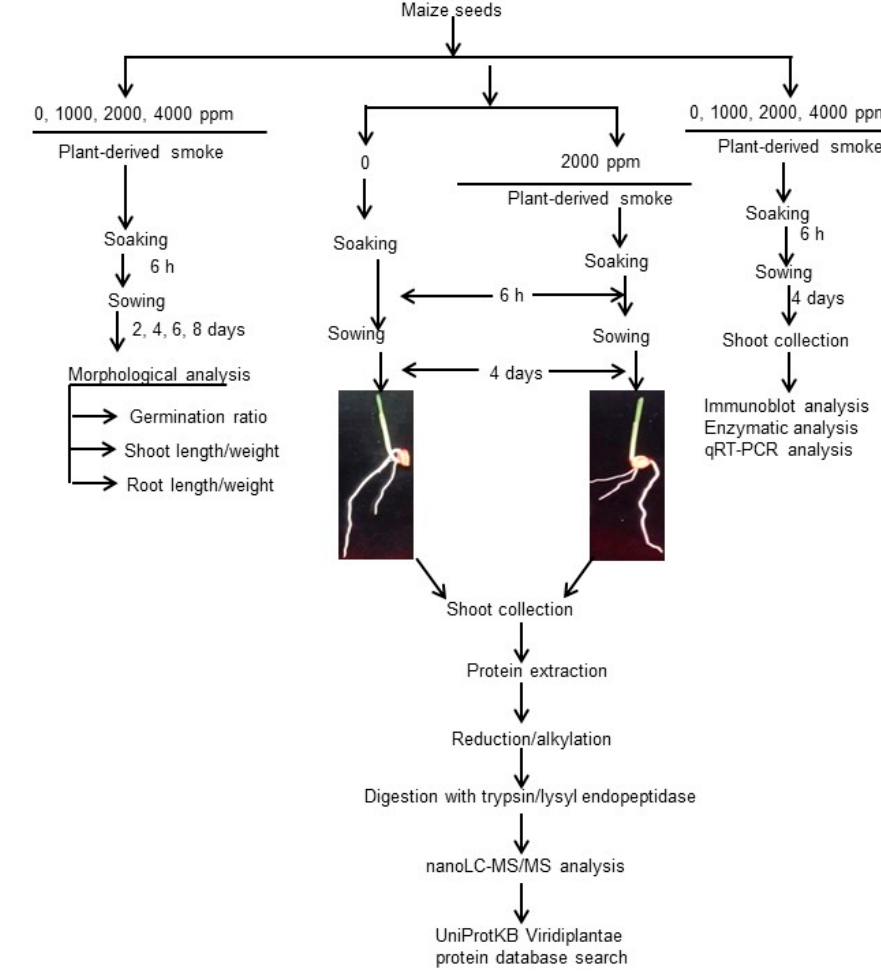
Figure 1. Experimental design for the effects of plant-derived smoke on maize growth. Maize seeds were soaked without or with 1000 ppm, 2000 ppm, and 4000 ppm plant-derived smoke for 6 h and grown in sand. For morphological analysis, germination ratio, shoot/root length, and weight were measured at 2, 4, 6, and 8 days. For proteomic analysis, maize seeds were soaked with 2000 ppm plant-derived smoke for 6 h. Shoot was collected after 4 days. Proteins were extracted, reduced, alkylated, digested, and analyzed by nano LC-MS/MS. For western blotting, maize seeds were soaked without or with 1000 ppm, 2000 ppm, and 4000 ppm plant-derived smoke for 6 h and grown in sand. Shoot was collected and proteins were extracted after 4 days for immune blotting analysis.